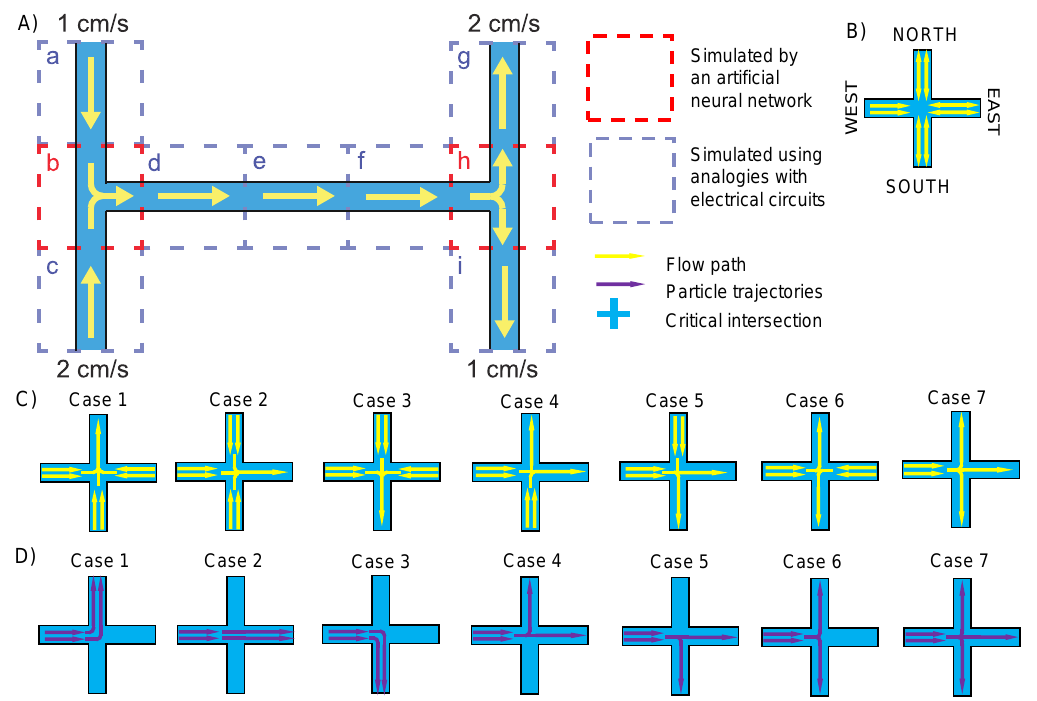
Figure 1. Theory of the design. ( A ) A basic “H” channel chip is decomposed into nine units (a to i) to demonstrate the straight channels and critical intersections. Units a, c, d, e, f, g, and i are straight channels, while units b and h are critical channel intersections. ( B ) Schematic of critical intersections. ( C ) Seven cases illustrating the fluid behavior at critical intersections. ( D ) Seven cases illustrating the particle behavior at critical